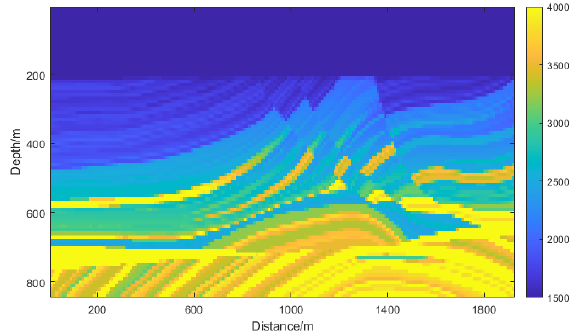
Figure 8. Complex model we used.